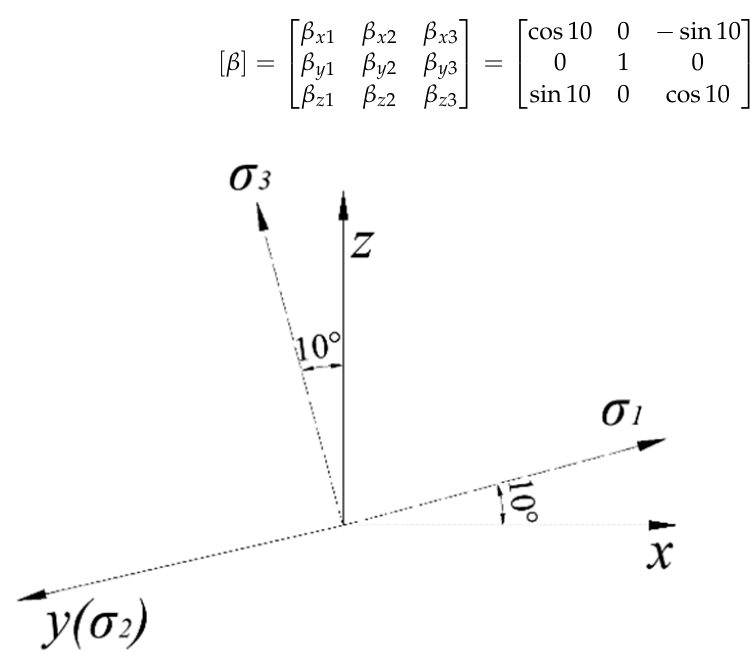
Figure 3. Direction of the stress. After transforming the principal stress into three directions x , y , and z as shown in Equation (21), the boundary conditions of the numerical model are shown in Figure 4.